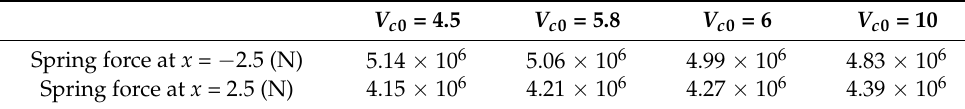
Figure 9. Force-displacement relationship for various values of the initial gas volume. Table 1. External loads and Spring forces at x = 2.5 and x = −